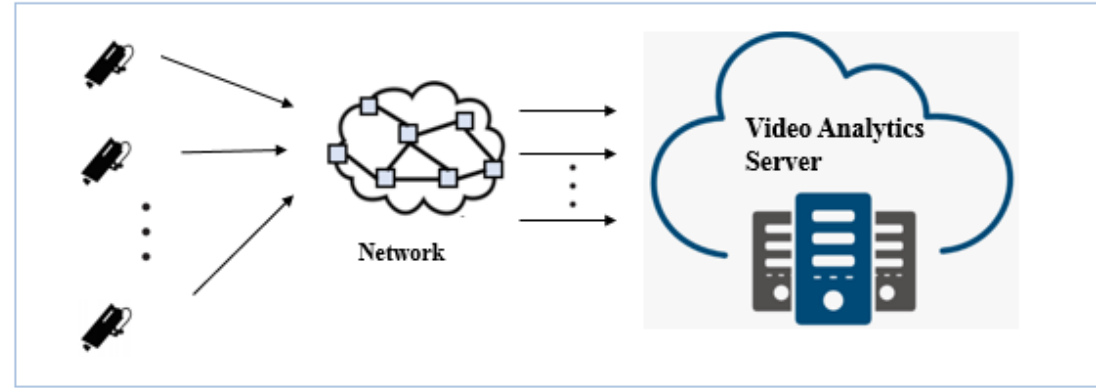
Figure 1. Overview of the cloud-based video analytics